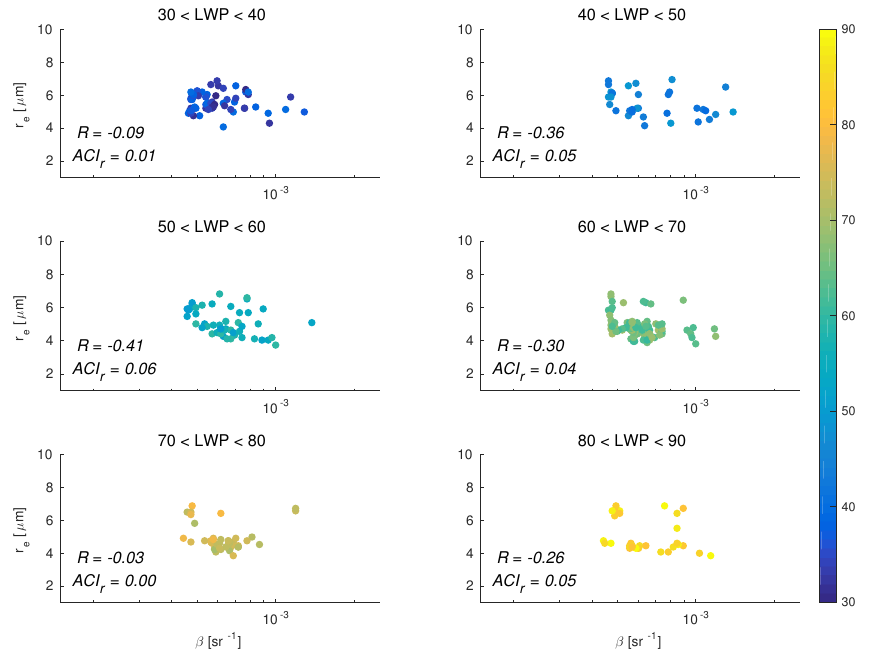
Figure 5. The values of the effective radius, r e , derived from WACR and MWR measurements are plotted versus the integrated attenuated backscatter ATB measured by Vaisala CT25K on 3 November 2009. Data are sorted by the values of LWP from the MWR. Every panel shows the corresponding value of ACI r (Eq. 5) and the Pearson product-moment correlation coefficient, R , for that LWP bin.